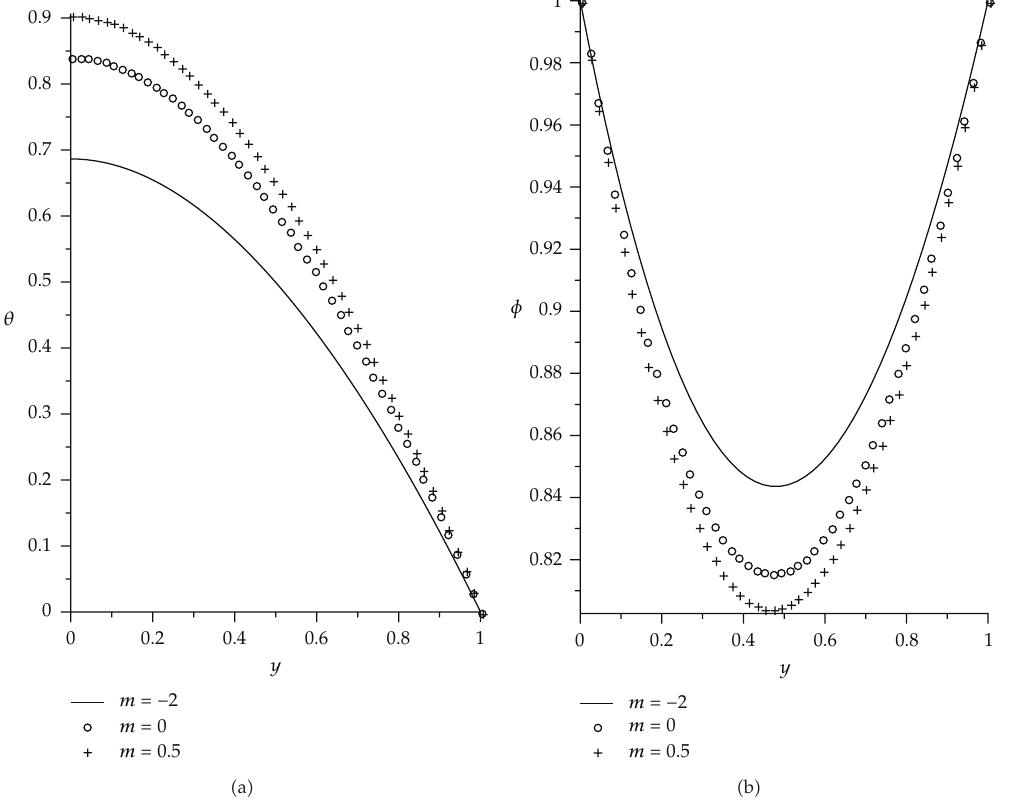
Figure 5: Temperature and oxygen concentration profiles for n (cid:8) β (cid:8) λ (cid:8) 1 , θ w (cid:8) 0 , ε (cid:8) 0 .